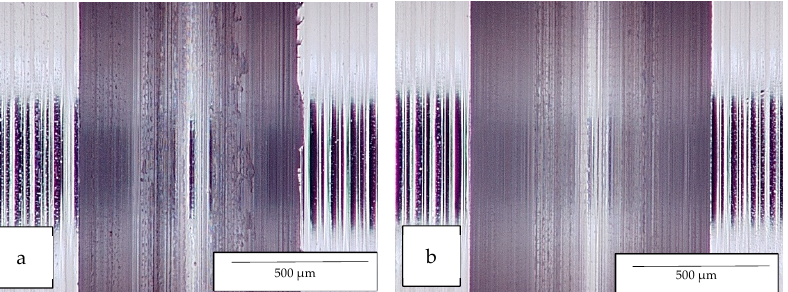
Figure 11. Representative images of the surface finishing of the notches for the ( a ) K890-I and ( b ) K890-II fatigue samples. ( b ) K890-II fatigue samples.